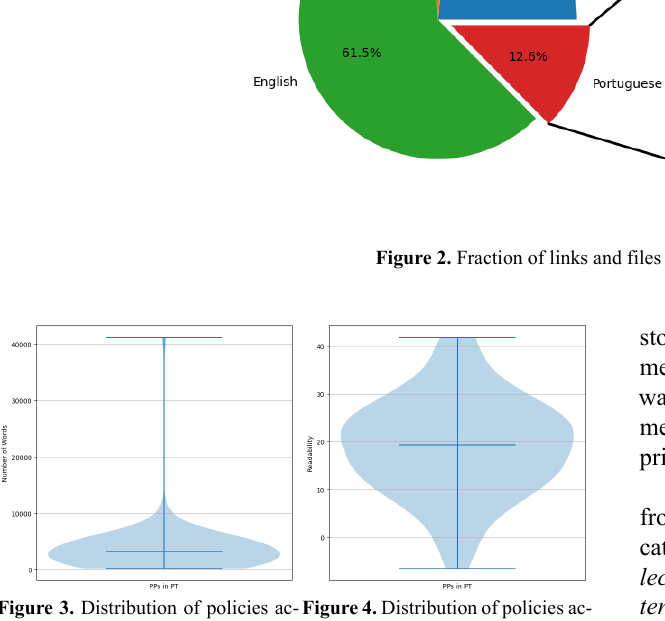
Figure 4. Distribution of policies ac- cording to readability level.